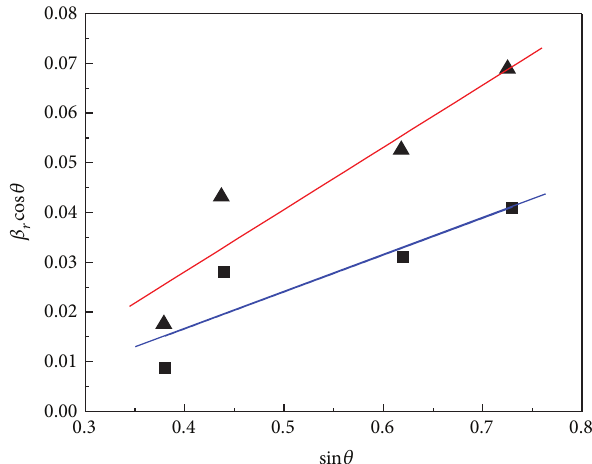
Figure 2: Williamson-Hall plot for XRD data of nickel powder (squares, blue line fit) and PVP-protected nickel particles (triangles, red fit